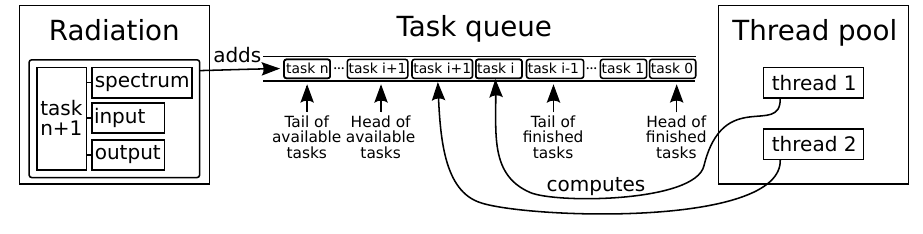
Fig. 2. Four instances of the array variable t , which extends over Fig. 1. A schematic overview of the CELL processor. The Pow- all layers of the column, are packed together into a single array of vectors. Fig. 1. A schematic overview of the CELL processor. The Pow-